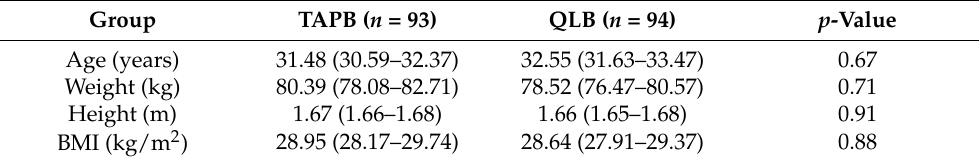
Figure 4. Study flowchart. Table 1. Patient demographic.